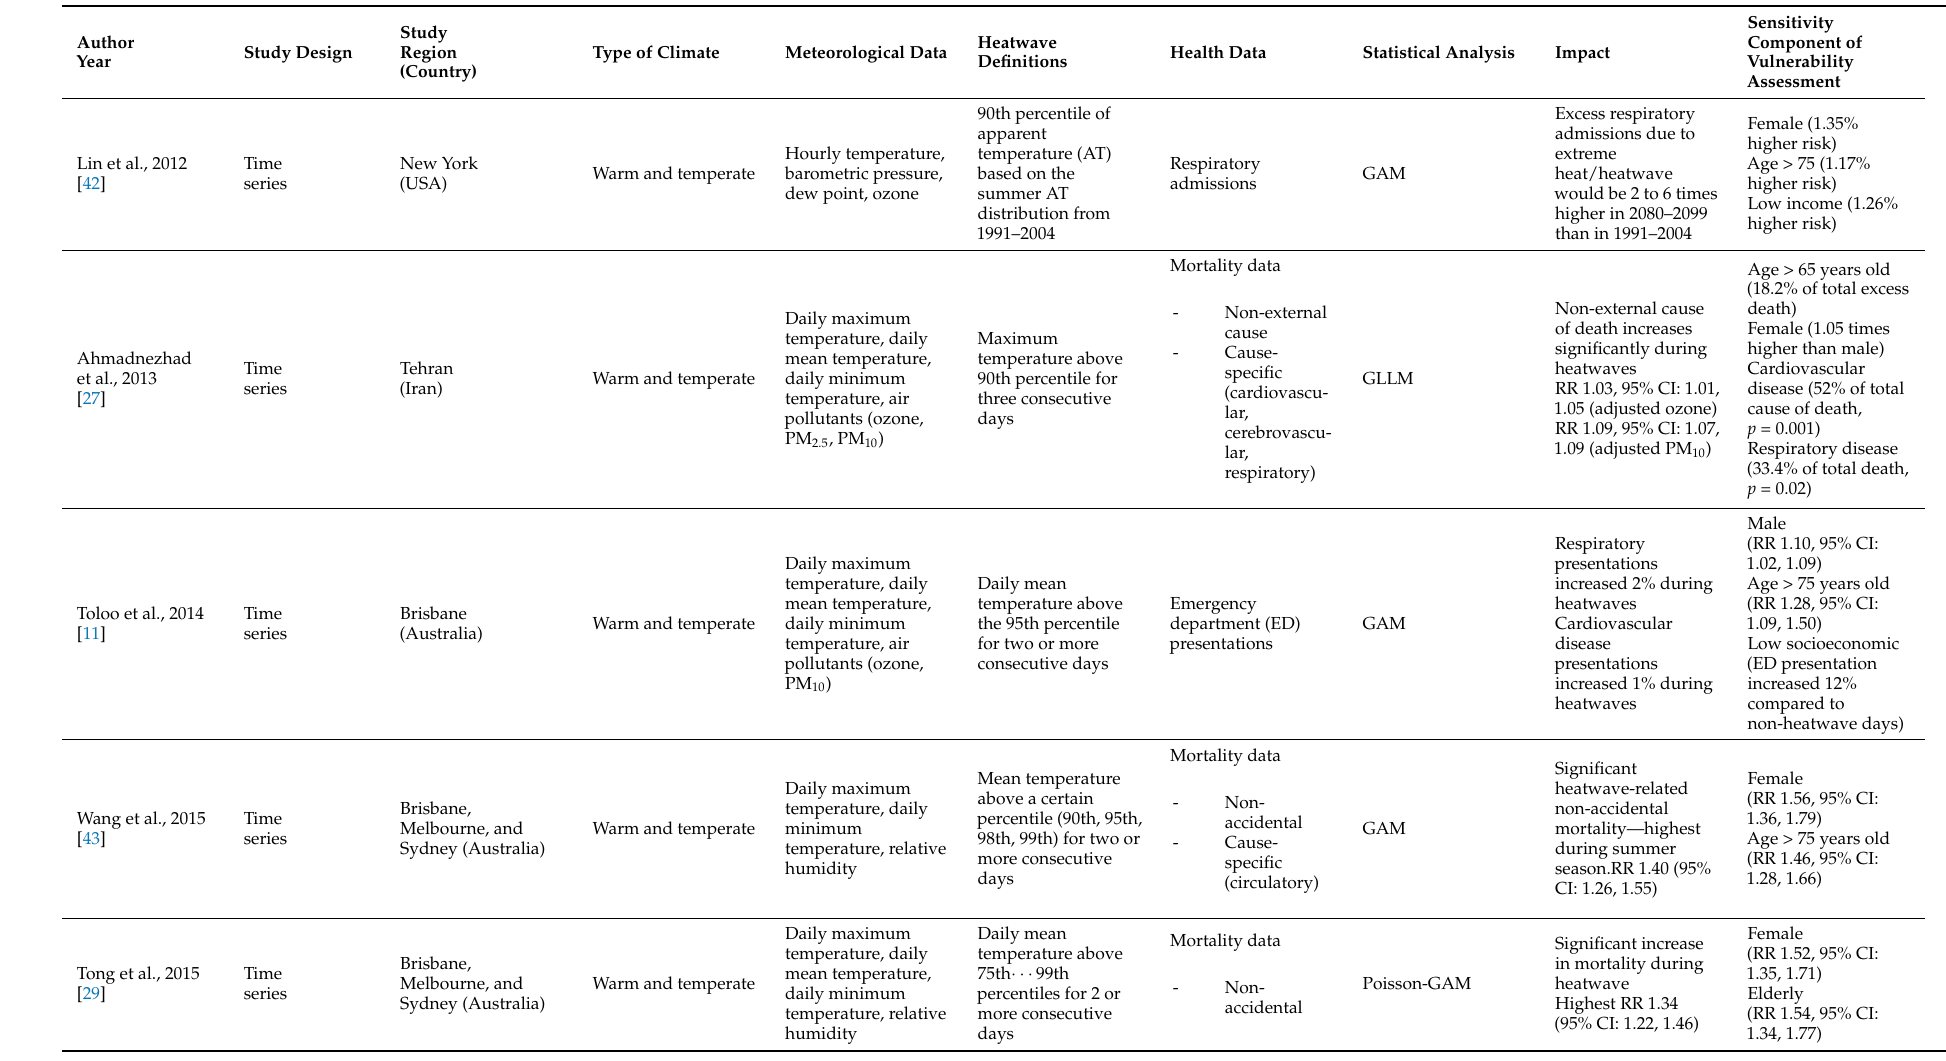
Table 1. Characteristics and main findings of the selected studies ( n =